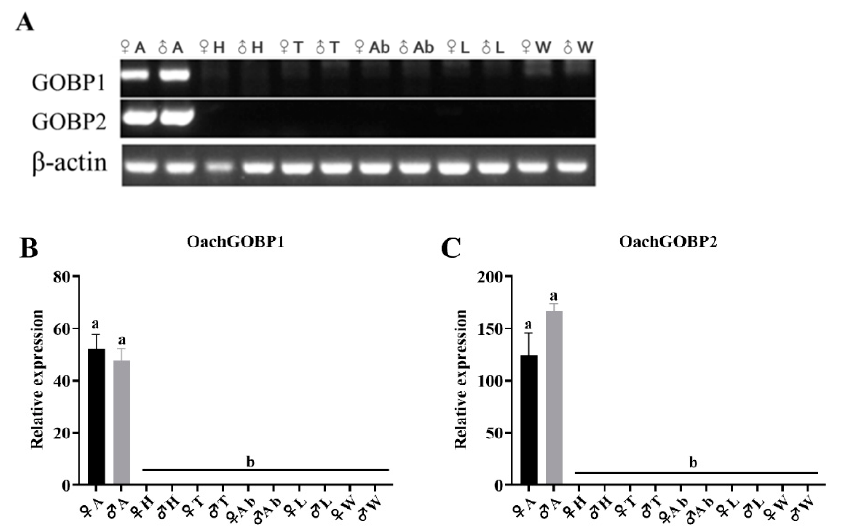
Figure 2. Expression profiles of OachGOBPs in O. achatina . ( A ): RT-PCR analysis of tissue expression of OachGOBPs with β -actin as reference gene. ♀ , female; ♂ , male. ( B , C ): qPCR analysis of relative expression (mean ± SE) in different tissues of OachGOBP1 and OachGOBP2, respectively. A: anten- nae; H: heads (with antennae and proboscises removed); T: thoraxes; Ab: abdomens; L: legs; W: wings.